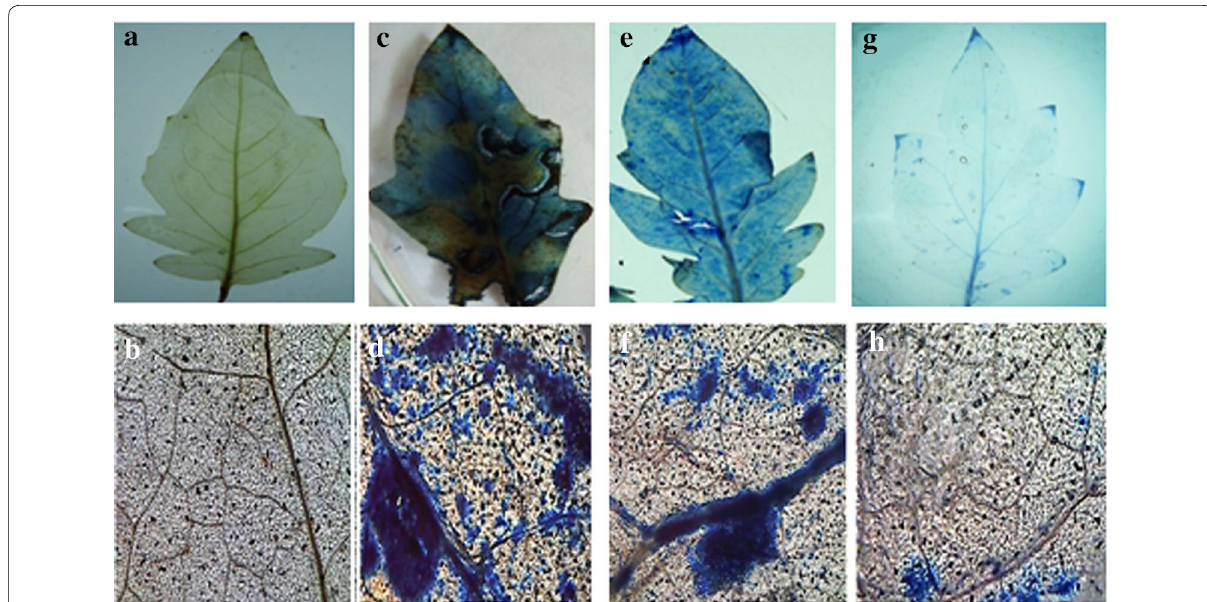
Fig. 2 Localisation of cell death (evans blue uptake) in different treatments of tomato leaves as revealed by blue stain. a , b Unchallenged control (control), c , d challenged with pathogen (Fol). e , f Pre-treated with SA and challenge inoculated with pathogen (Fol harzianum (Th), MeJA and challenge inoculated with pathogen (Fol